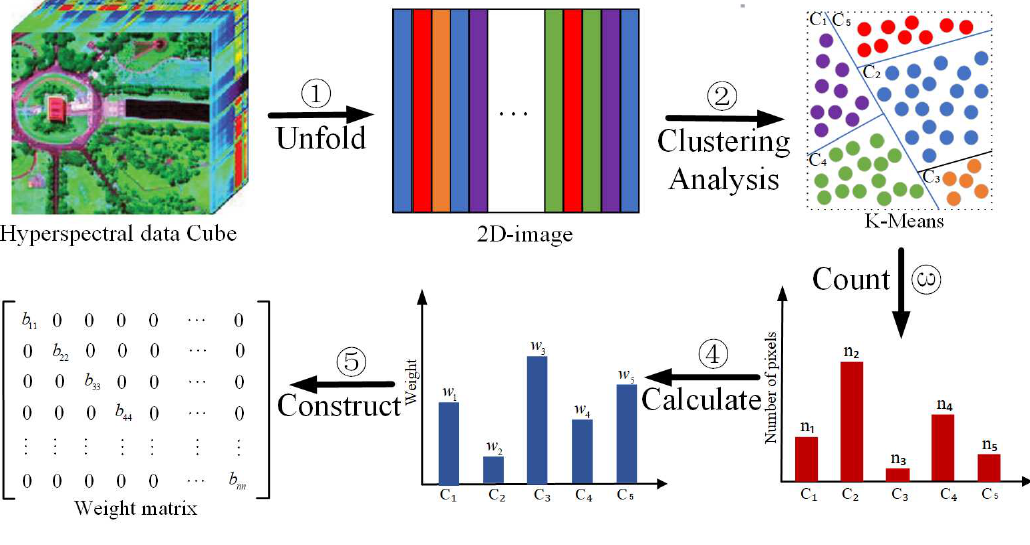
Figure 1. Flow chart of the construction process of the weight matrix. First, the hyperspectral data cube is unfolded into a 2D matrix with each column denoting a pixel. Then, the K -means method is applied to generate K clusters where K equals to the number of endmembers P (here, P = 5). Based on the clustering results C = ( C 1 , C 2 , C 3 , C 4 , C 5 ) , we count the number pixels n k in each cluster C k , where k = 1,2, . . . ,5. Next, we obtain the weight value w k , ( k = 1,2, . . . ,5 ) for cluster C k with Equation (15). Finally, to assign a weight value b ii to each pixel y i in cluster C k , we construct a weight matrix by designating b ii as its diagonal